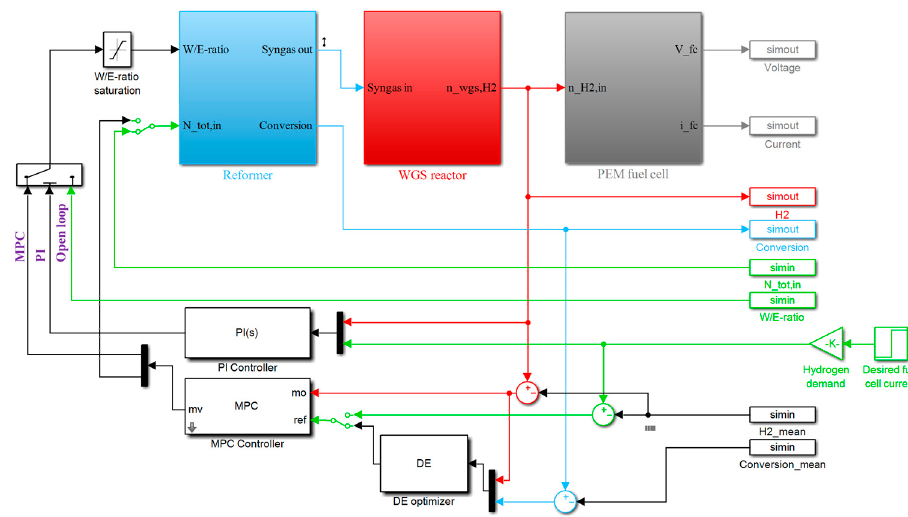
Figure 2. The simulation model. On top of the figure, the three process models are masked into the respective subsystems. On right hand side of the figure, the data communication between Simulink and Matlab workspace is established. The different control options are depicted in bottom of the figure, and finally the selection between the open loop, Proportional-Integral (PI) control, and Model Predictive Controller (MPC) operation can be made on the left hand side of figure.